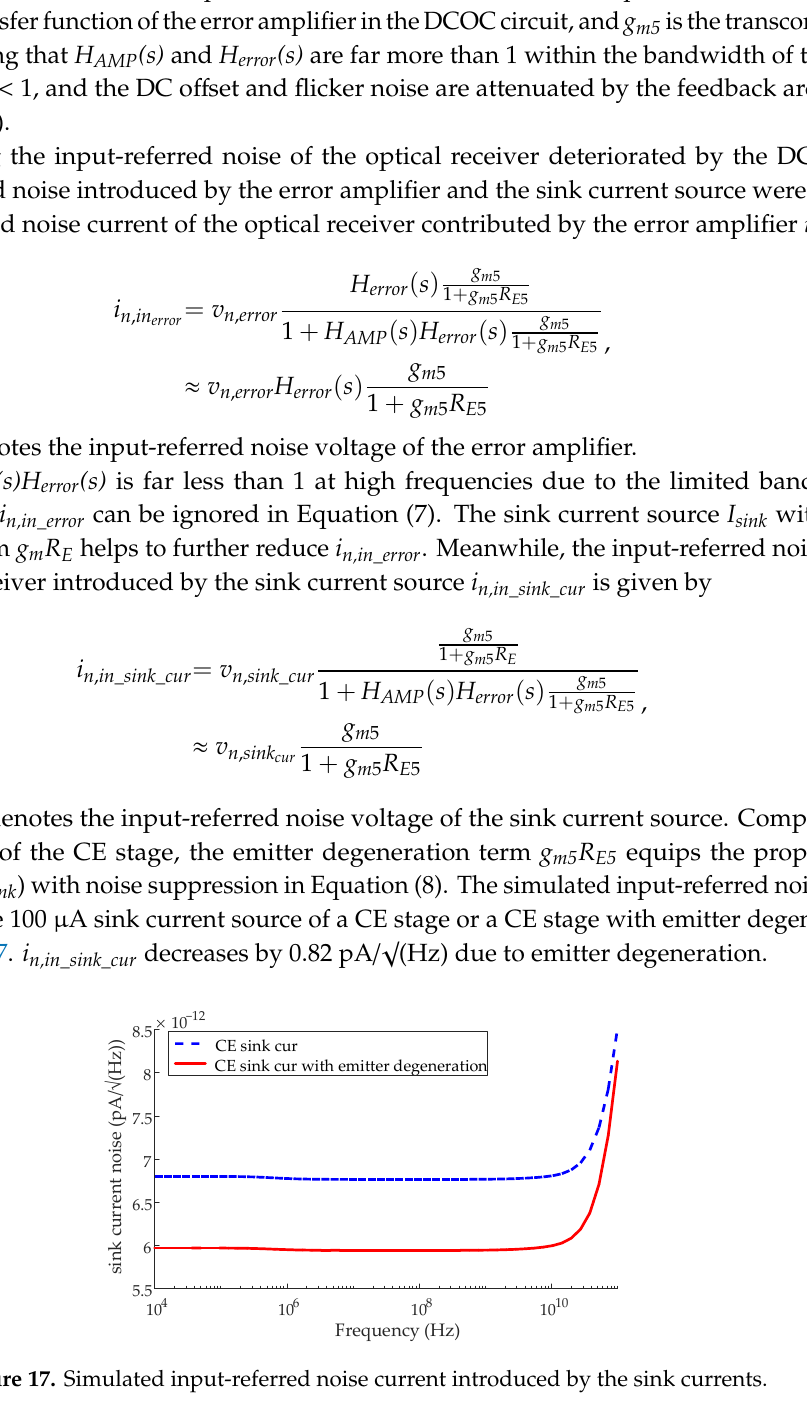
Figure 18. The microphotograph of the four-lane optical receiver. In order to explore the eye diagram performance of the optical receiver, an INOPOTICALS Bit Analyzer BA8042 (INOPOTICALS, Taiwan) was used to produce 2 7 − 1 pseudo-random bit sequence (PRBS7) data patterns to the optical receiver, while a Keysight digital signal analyzer DSAZ254A (Keysight, Santa Rosa, CA, USA) was used to measure the output eye diagram. The Bit Analyzer BA8042 was also implemented to measure the BER performance with a given PRBS7 input signal. The measured eye diagrams with a 300 μApp input signal (for PRBS7) are presented in Figure 19a,b, where the receiver works in high-power mode. The measured results of the eye diagrams in Figure 19 a,b are given in Table 1. The eye heights with input signals at 25 Gb/s and 28.9 Gb/s are 154.2 mV and 114.8 mV, respectively. The eye diagram at 25 Gb/s has a much larger eye height than the eye diagram at 28.9 Gb/s. The crossing of the eye diagram become larger with higher data rates, as shown in Table 1. Additionally, the measured BER of the optical receiver with a 200 μApp input signal varying from 25 Gb/s to 28.9 Gb/s (for PRBS7) is 10 −12 when the receiver works in both high-power mode and low-power mode.